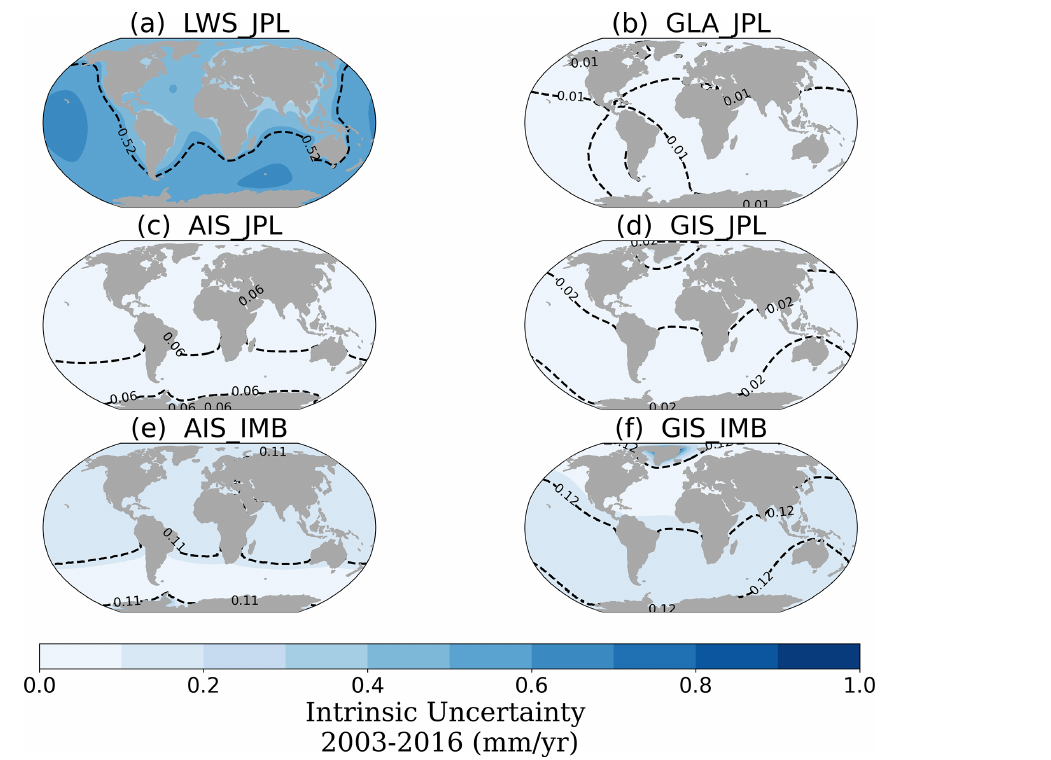
Figure 6. GRD-induced sea-level fields of the intrinsic uncertainty (mmyr − 1 ) for the land water storage (a) , glaciers (b) , Antarctica (c) and Greenland (d) contributions of the JPL dataset and Antarctica (e) and Greenland (f) contributions of the IMBIE dataset. The black dashed contour line indicates the spatial average of the regional